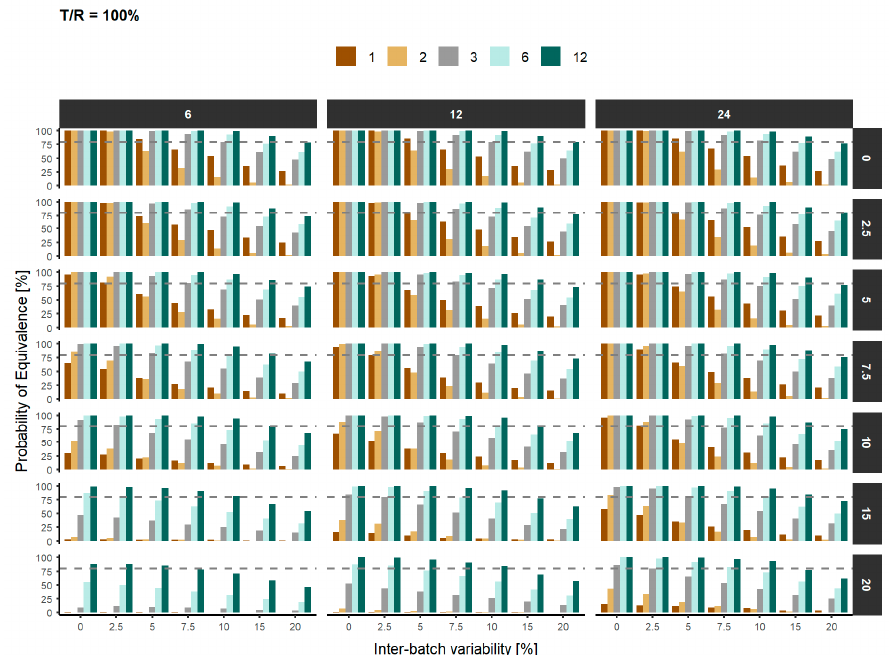
Figure 2. Probability of declaring similarity based on the inter-batch variability and the number of batches (brown: 1, gold: 2, grey: 3, light green: 6 and dark green: 12). Top panels represent the number of units and right panels represent the intra-batch variability. The grey dashed line represents the statistical power to declare equivalence between both products (80%).